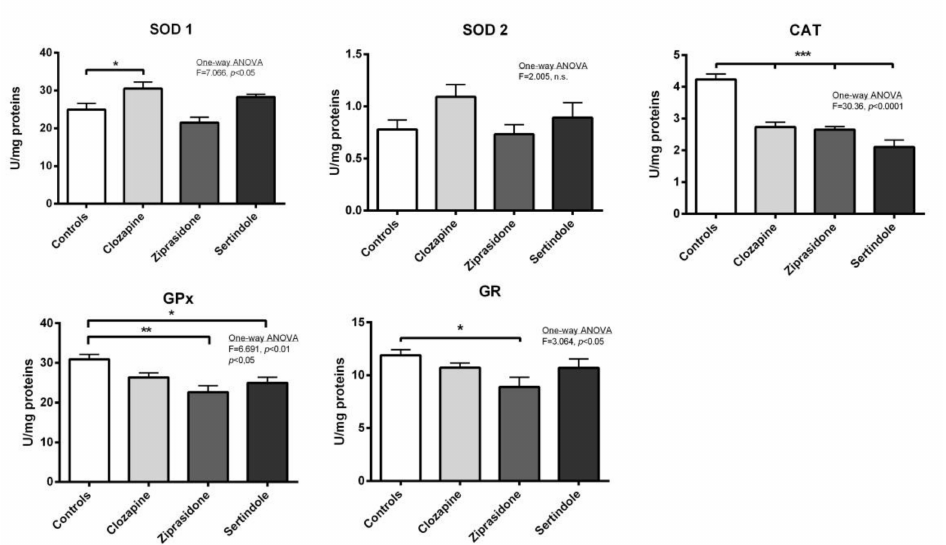
Figure 4. Activities of testicular antioxidant defence enzymes in rats after treatment with clozapine, ziprasidone and sertindole. SOD1, SOD2, CAT, GPx and GR activities were measured in control- and clozapine-, ziprasidone-and sertindole-treated rats. The values represent the means ± SEM. Statistical significance of the difference between experimental groups (one-way ANOVA): * p < 0.05, ** p < 0.001 and *** p < 0.001.